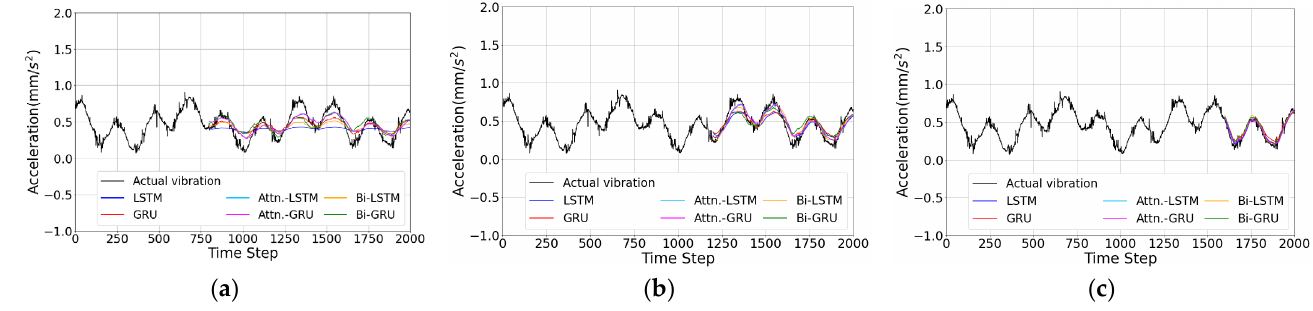
Figure 10. Waveforms of the vibrations predicted from the abnormal vibrations: ( a ) 40%, ( b ) 60% ( c ) 80% segments of training data.